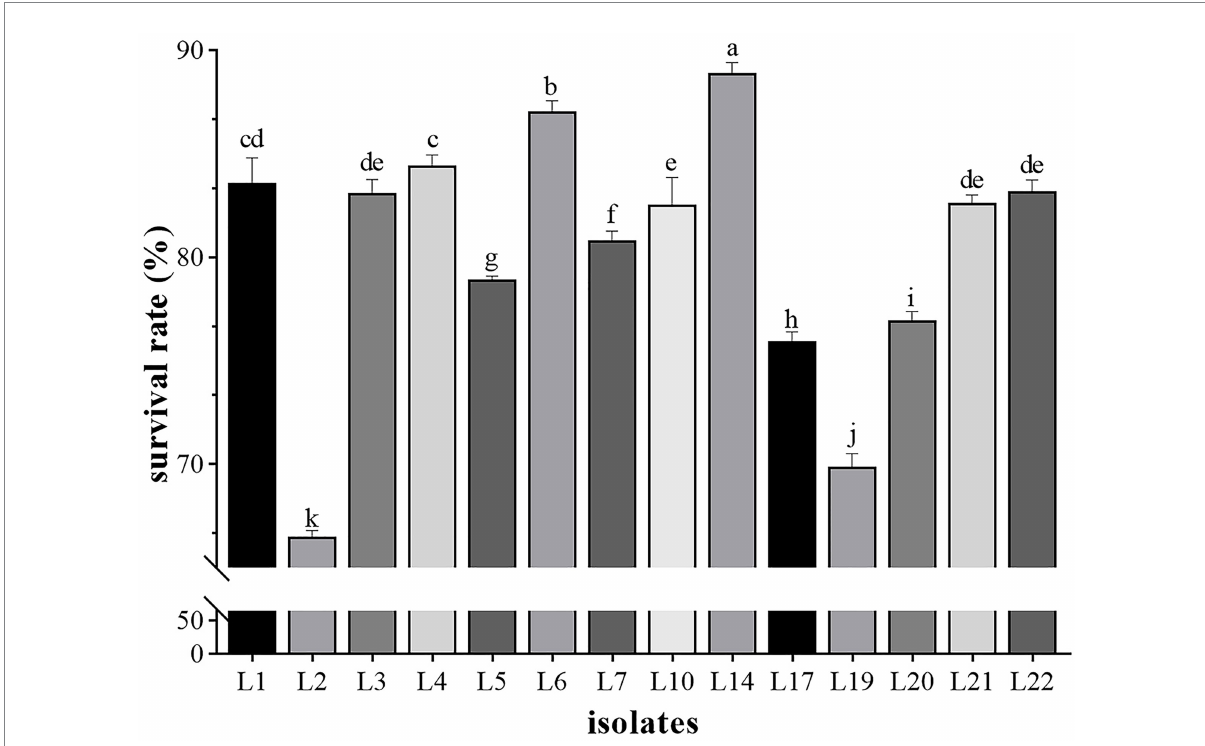
FIGURE 2 The results of phenol tolerance of 14 LAB isolates. Results are expressed as mean ± SD of triplicate tests. a-k Values in a column with different superscript letters are significantly different (Waller-Duncan, p <